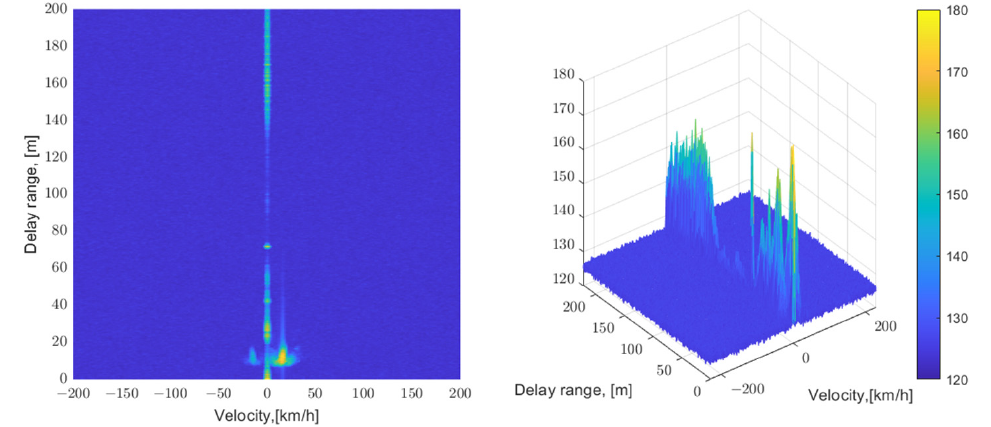
Figure 18. Range-Doppler map of a target moving at 20 km/h.